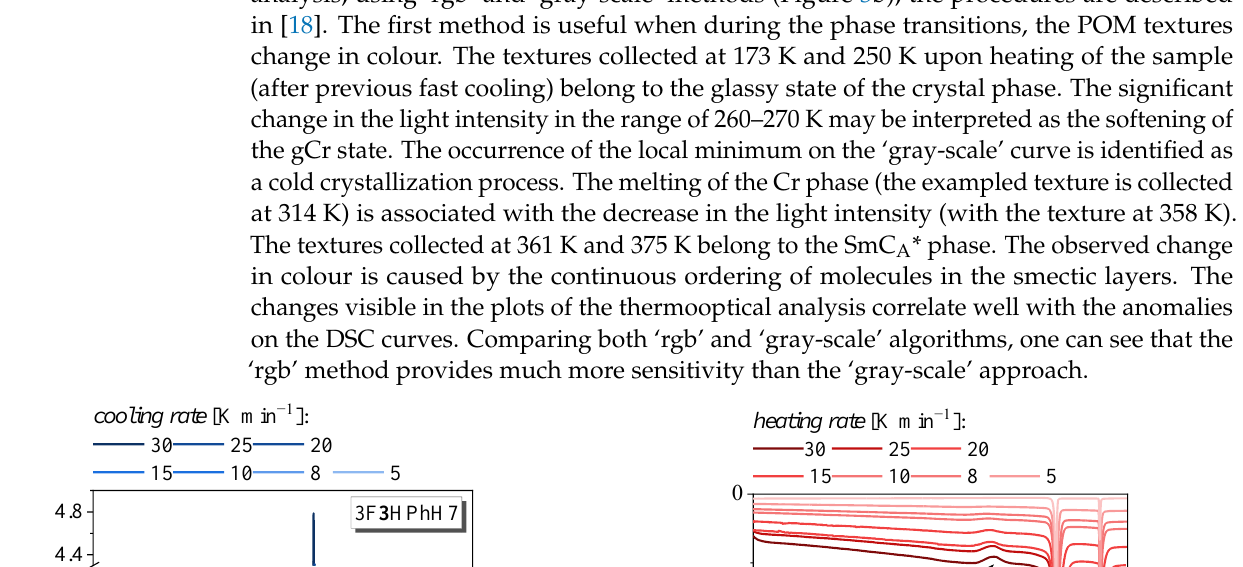
Figure 2. DSC curves of the 3F 3 HPhH7 collected for various cooling ( a ) and heating ( b ) rates. Further, the characteristic kink is observed at 247 K, which is the signature of the glass transition (Figure 3a) [23]. Many orientationally disordered (ODIC) as well as CONDIS crystal phases have a tendency to vitrification [24,25]. Upon heating, a wide anomaly with the onset temperature of 308 K is interpreted as the cold crystallization process (Figure 2b). The melting of Cr phase occurs at 357 K with the largest changes of enthalpy ∆ H = 24.1 kJ mol −1 and entropy ∆ S = 67.2 J mol −1 K −1 (values for the rate of 10 K min −1 ), (Figure 2b). The last anomaly, at 383 K, is associated with the SmC A * — Iso phase transition (Figure 2b).